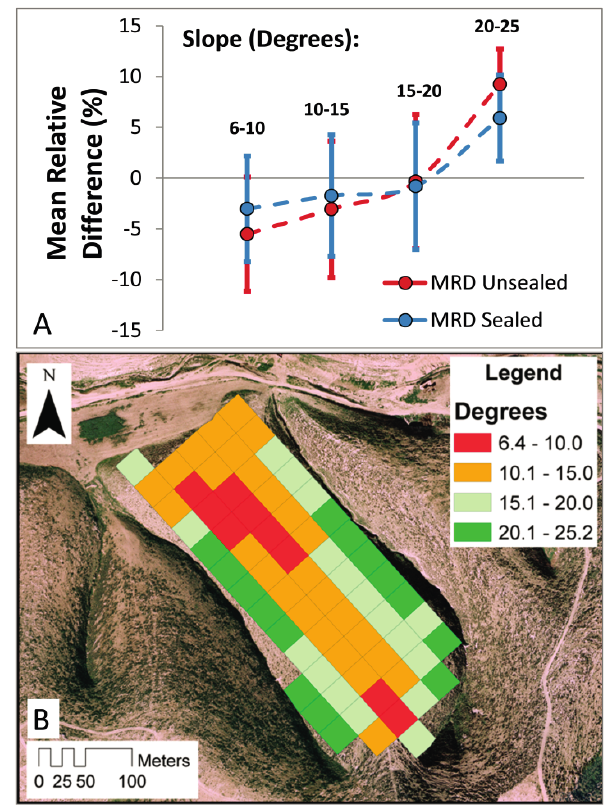
Figure 7. The mean soil moisture MRD in the 30-m cells, based on 20 y of climatic data. ( A ) The sealed (blue) and unsealed (red) systems are delineated into four zones based on the slope inclination in each cell. The vertical error bars represent one standard deviation of the MRD value in each category/zone. ( B ) The spatial distribution of the respective slope inclination zones along the hillslope is